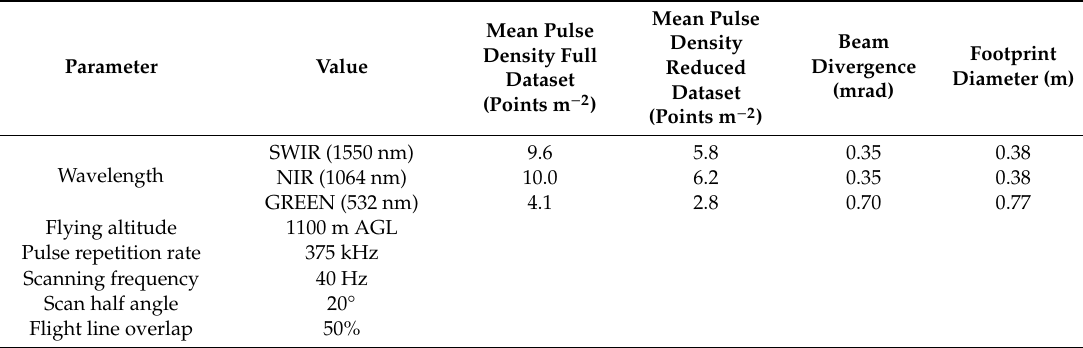
Table 2. M-ALS (Optech Titan) acquisition specifications. SWIR–short-wave infrared; NIR–near-infrared; AGL–above ground